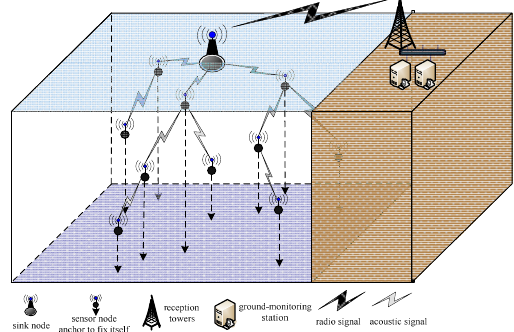
Figure 1. Underwater wireless sensor network (UWSN) system model.